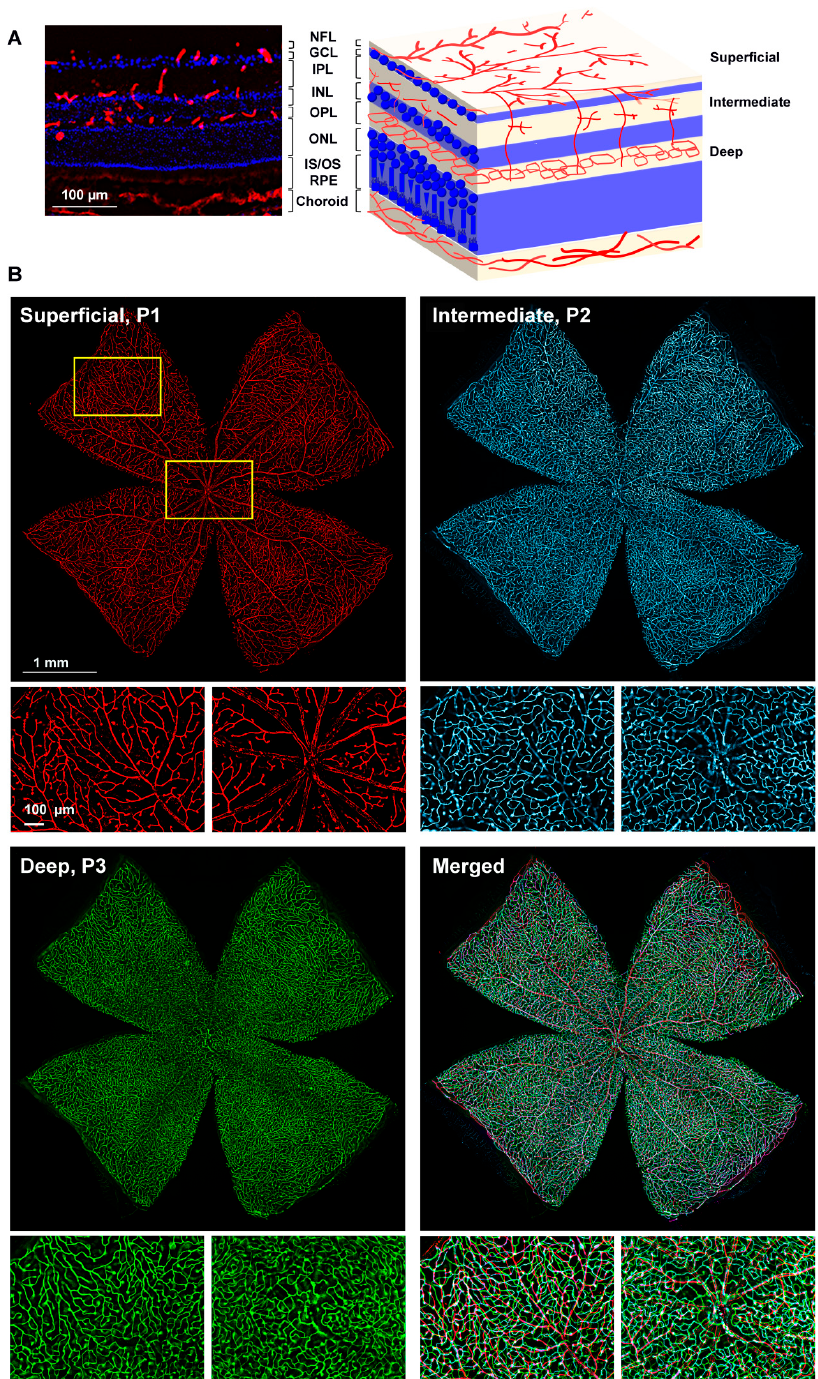
Figure 3. Retinal vascular plexuses. ( A ) Left: Ly6c immunodetection (red) in a retinal cross-section counterstained with DAPI (blue). Right: drawing depicting the retinal layers and the position of each vascular plexus. RGCL: retinal ganglion cell layer, IPL: inner plexiform layer, INL: inner nuclear layer, OPL: outer plexiform layer, ONL: outer nuclear layer. ( B ) Whole-mounted retina showing Ly6c staining in the three retinal vascular plexuses. Below each one there are magnifications from the two regions framed in yellow. 1 mm and 100 µ m scale bars are for photomontages and magnifications,